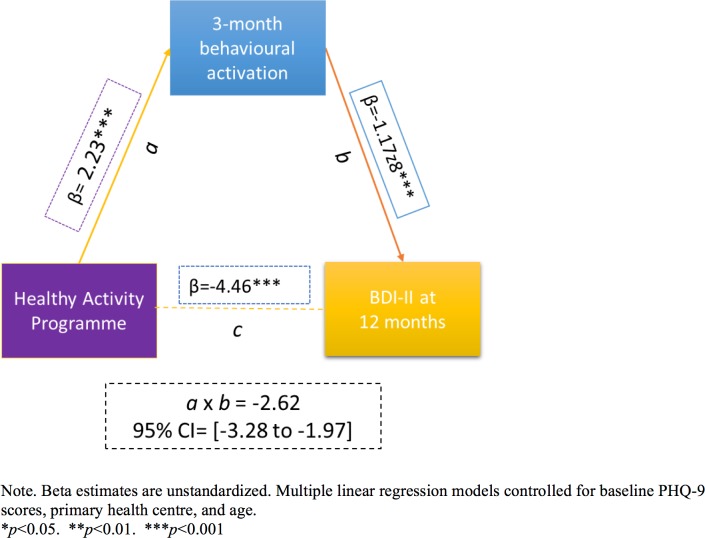
The mediating effect of behavioural activation at 3 months on the effectiveness of the HAP on depression severity at 12 months.Variables as follows: β, Beta coefficient; a, a-path (HAP–mediator); b, b-path (mediator–outcome); c, direct effect (HAP–outcome); a × b, indirect effect. BDI-II, Beck Depression Inventory–II; PHQ-9, Patient Health Questionnaire 9.